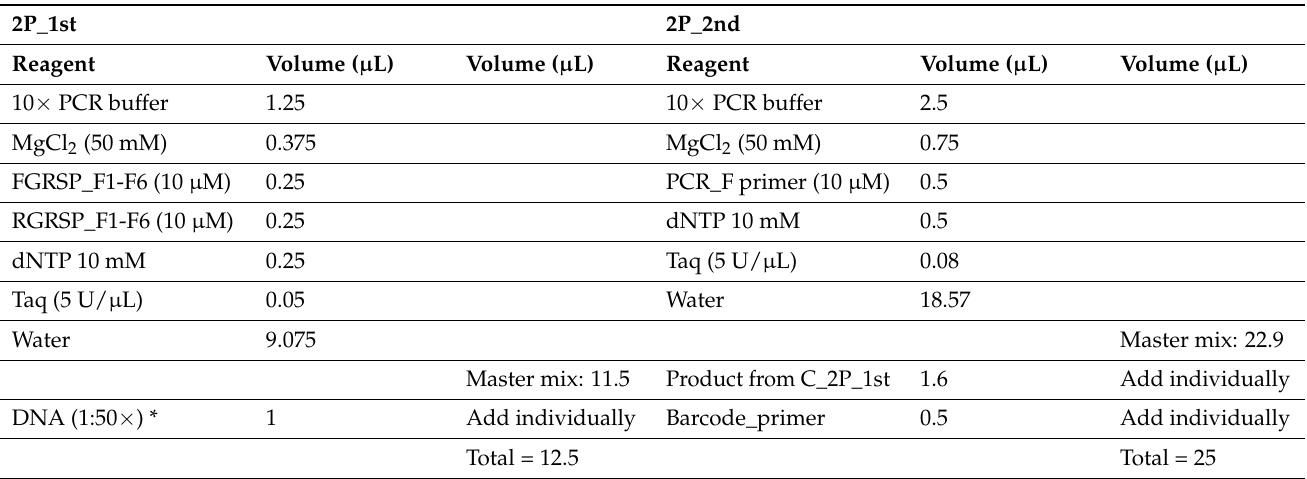
Table 3. PCR mix recipes for two-step PCR